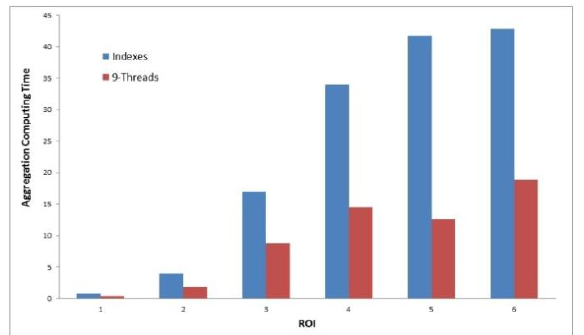
Figure 7.Comparison of spatiotemporal aggregation query efficiency between the structure of multiple indexes